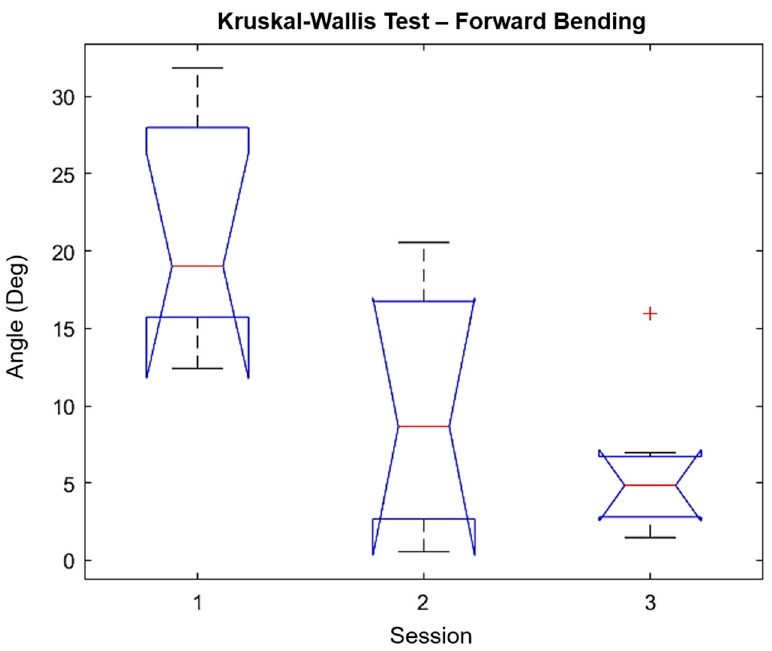
Table 7. Mean ranks for forward/backward bending in degrees.